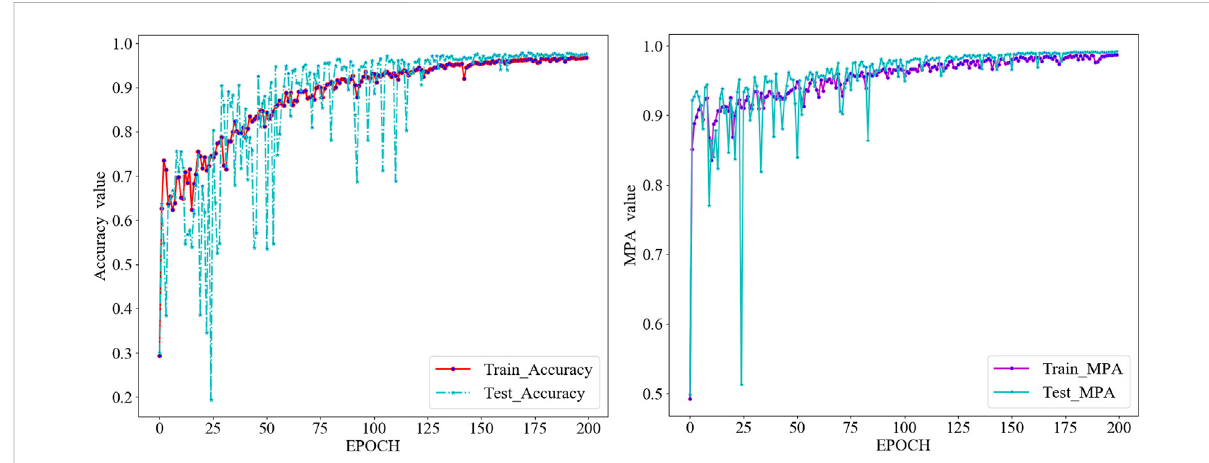
FIGURE 12 Model training land surface re fl ectance support accuracy and MPA vs. epoch.